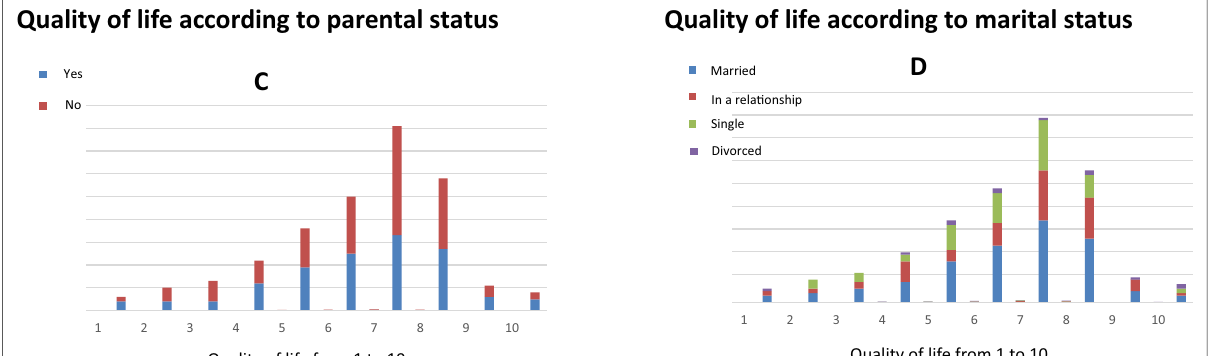
Fig. 2 The evaluation of quality of life according to the numbers of working hours ( a ), their academic status ( b ), marital status ( c ) and parental status ( d